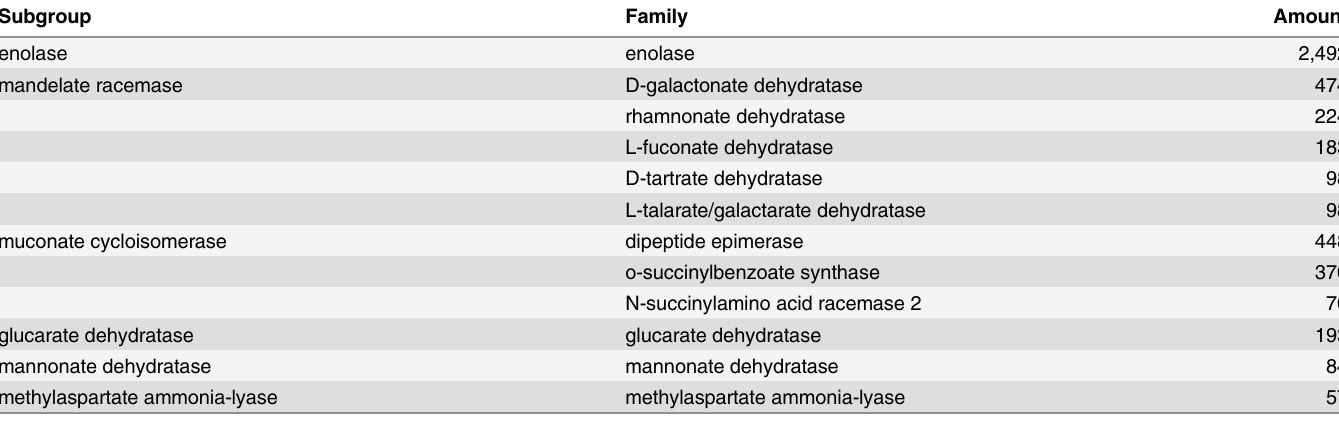
After applying the filtering process described in the “ Protein family definition ” subsection to the 31,182 enolase superfamily proteins with known families in the SFLD [57], 4,791 pro- teins remained, distributed among six subgroups and twelve families. The superfamily distribu- tion is presented in Table 13. Table 13. Distribution of the enolases among subgroups and